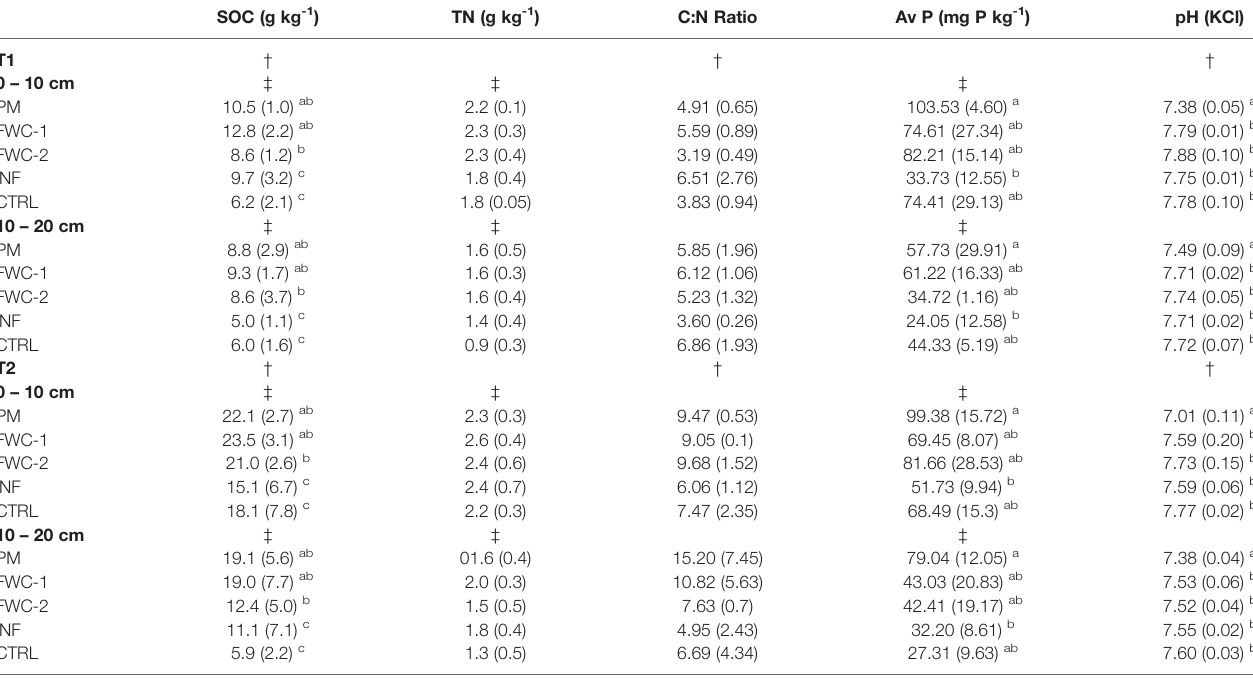
TABLE 7 | Mean values of soil organic carbon, total nitrogen, carbon-to-nitrogen ratio, available phosphorus, and pH at time T1 (Dec 2017) and time T2 (Jan 2018) in the upper (0-10 cm) and lower (10-20 cm) depths for all treatments (food waste composts FWC-1 and FWC-2), poultry manure (PM), inorganic nitrogen fertilizer (INF), and control